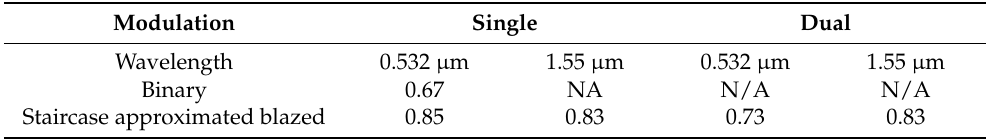
Table 1. Modulation-, binary-, and staircase-approximated blazed grating of MEMS-PLM and optical